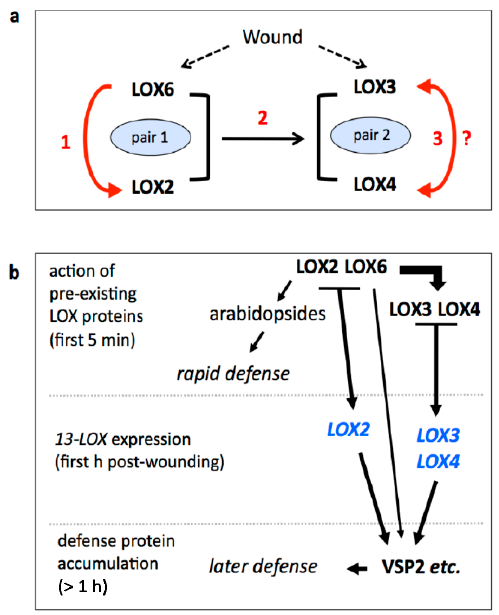
Figure 6. 13-LOX activities in wounded Arabidopsis leaves. ( a ) 13-LOXs interact through jasmonate production. 1. LOX6 participates in the production of jasmonate that upregulates LOX2 expression (from Figure 2). 2. LOX6 and LOX2 together produce jasmonates that enhance LOX3 and LOX4 expression (from Figure 2). 3. Still hypothetical, LOX3 and LOX4 may enhance each other’s expression through jasmonate production; ( b ) 13-LOX roles in the wound response. Preformed LOX2 rapidly produces arabidopsides, secondary compounds implicated in direct defense [17]. LOX6 and LOX2 produce jasmonates necessary for early gene expression (e.g., JAZ10 ; 9,15 and LOX3/4 expression; Figures 2 and 4). LOX3 and LOX4 produce jasmonates that ensure correct late-phase VSP2 gene expression (from Figures 3 and 4). Proteins, black; transcripts, blue.